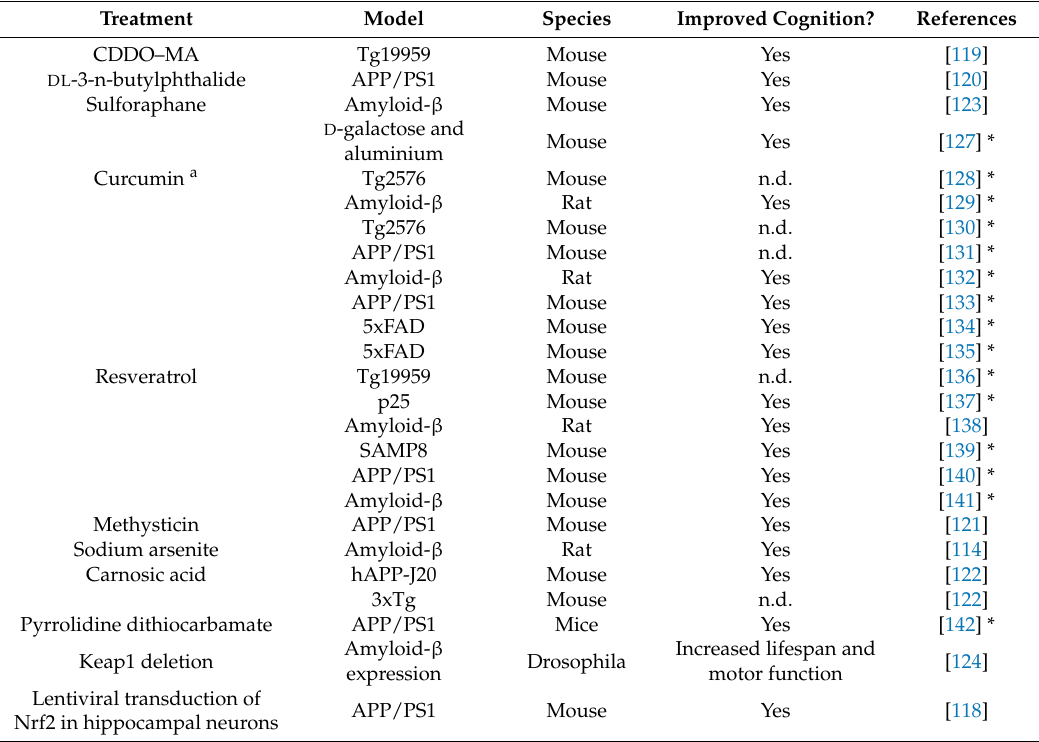
Table 4. Preclinical studies on Nrf2 activation in animal models of Alzheimer’s